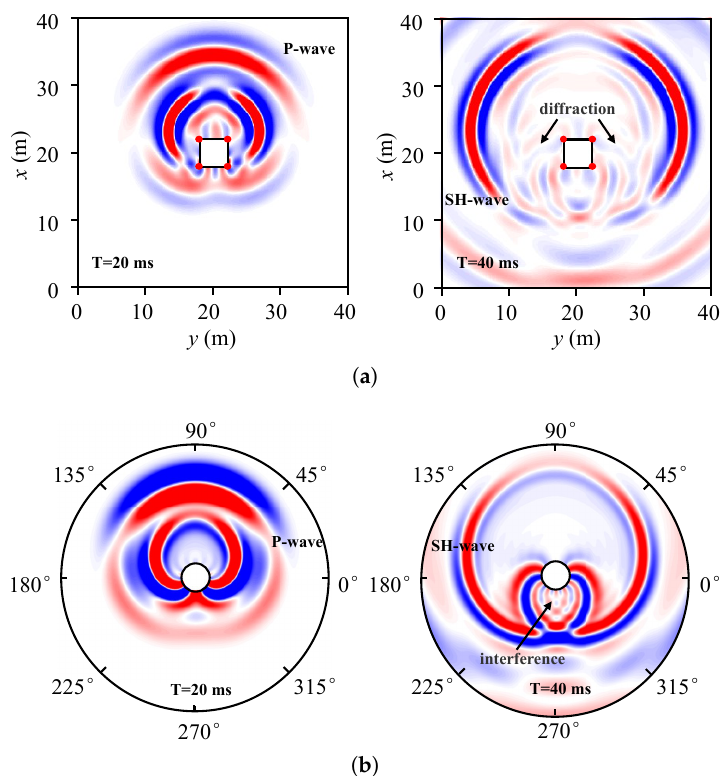
Figure 10. Wavefield results in ro θ plane. Wavefield results at different time ( a ) in the cylindrical coordinate system and ( b ) the Cartesian coordinate